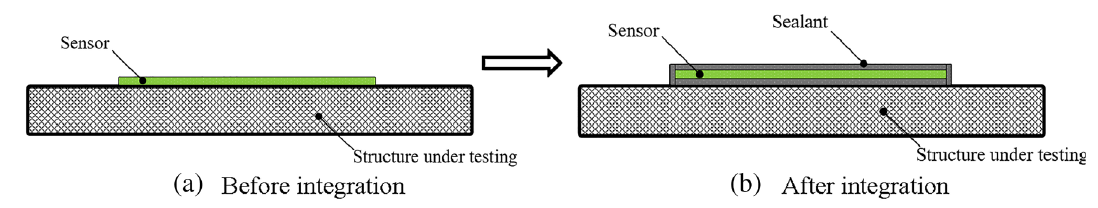
Figure 4. Schematic diagram of sensor